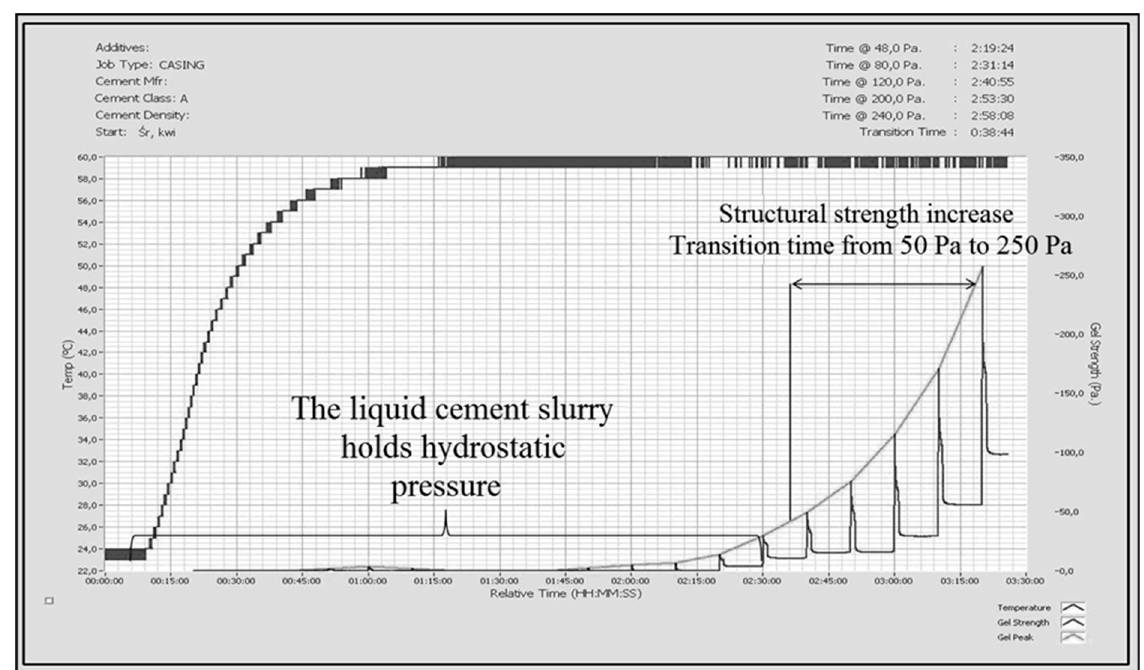
Figure 5. Diagram for the build-up of static structural strength and the formation of a transition period.